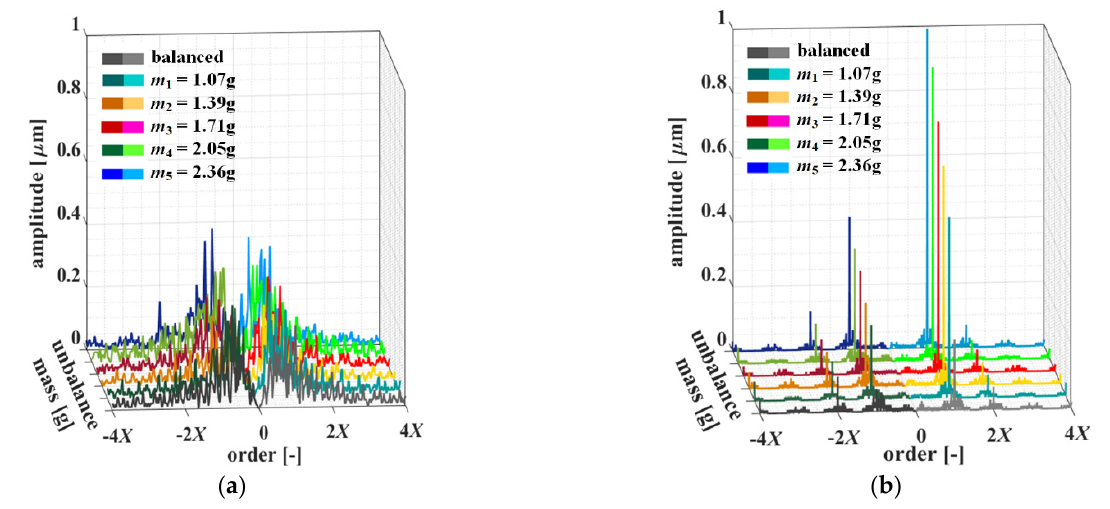
Figure 11. Spectra of FS analysis as a function of unbalance mass, m n , for speeds n 1 = 300 rpm ( a ) and n 6 = 1500 rpm ( b ). and n 6 = 1500 rpm ( b ).